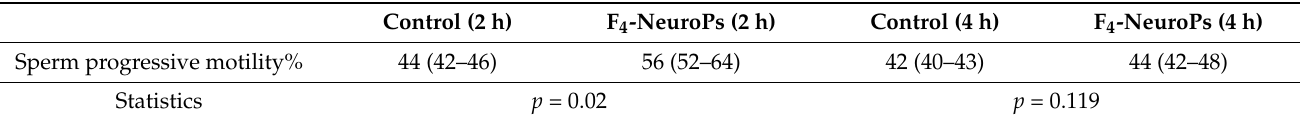
Table 1. Median (IQR) percentage of total progressive sperm motility evaluated by computer-assisted sperm analyzer (CASA) after incubation with 7 ng F 4 -NeuroPs and without F 4 -NeuroPs (control) for 2 and 4 h. Statistics are also reported; p < 0.05 is considered